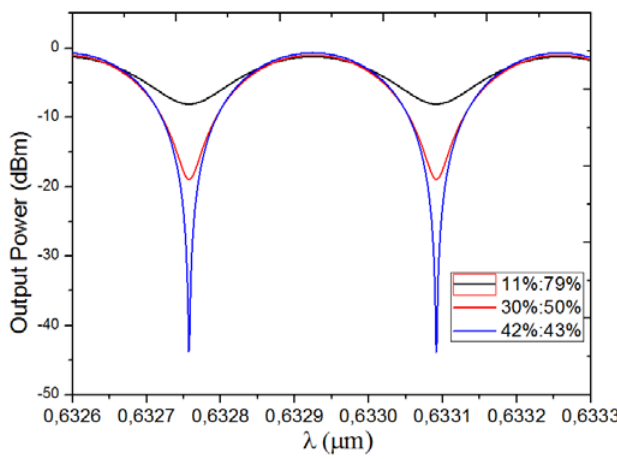
Figure 6. Output power spectrum for different power ratios.